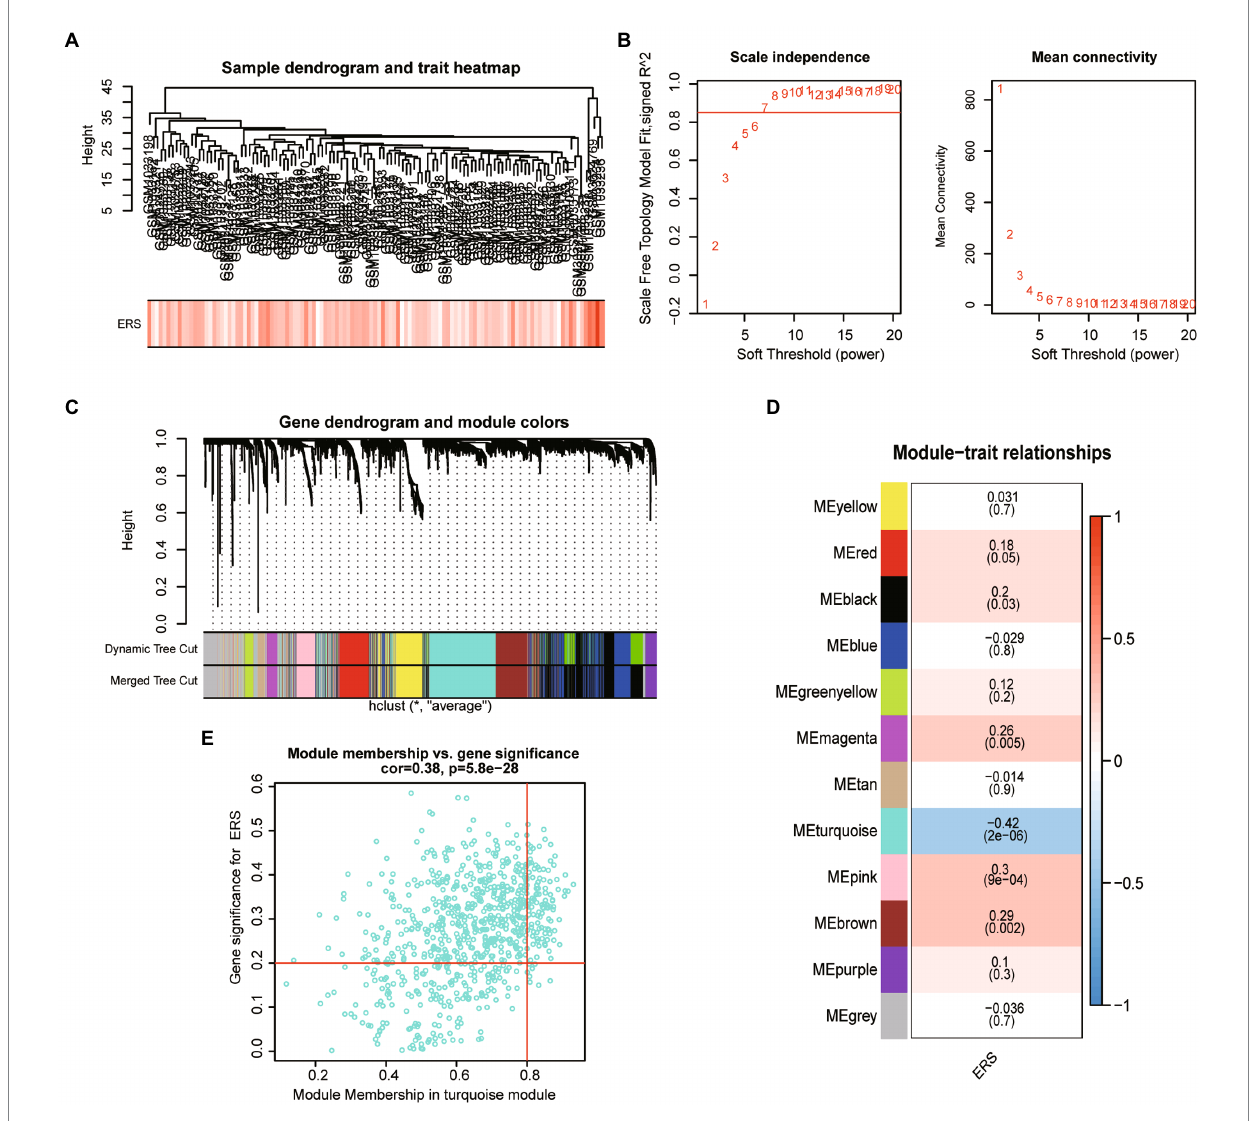
FIGURE 3 The weighted gene co-expression network analysis. (A) Clustering dendrogram of ASD sample with trait heatmap. (B) The scale-free topology model fit ( R 2 ) (left) and the mean connectivity of the co-expression network (right) given different soft-thresholding powers. (C) Gene dendrogram obtained by average linkage hierarchical clustering. The color row underneath the dendrogram shows the module assignment determined by the Dynamic Tree Cut. (D) Heatmap of the correlation between module eigengenes and ER stress score. (E) The scatterplot of gene significance (GS) for ER stress score vs. module membership (MM) in the turquoise